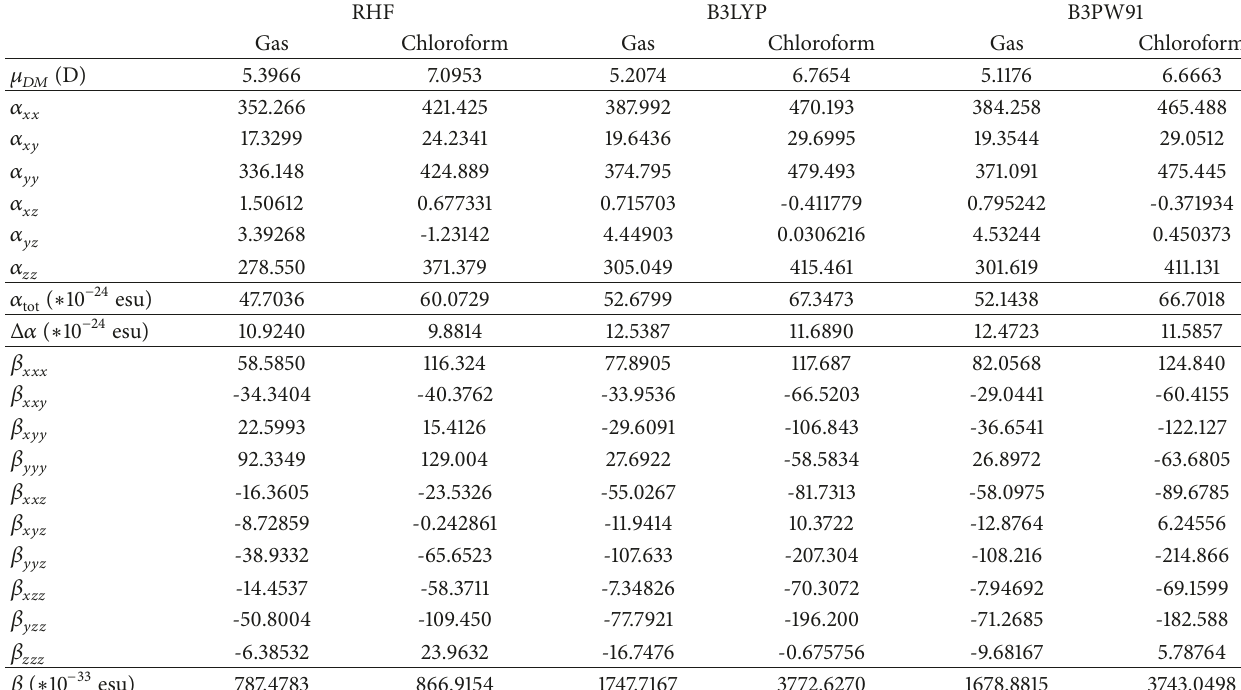
Table 5: Electric dipole moment, polarizability, anisotropy of polarization, first-order hyperpolarizability, and molar refractivity of Rubescin E at the RHF, B3LYP, and B3PW91 levels with the 6-311G (d, p) and 6-311++G (d, p) basis sets.